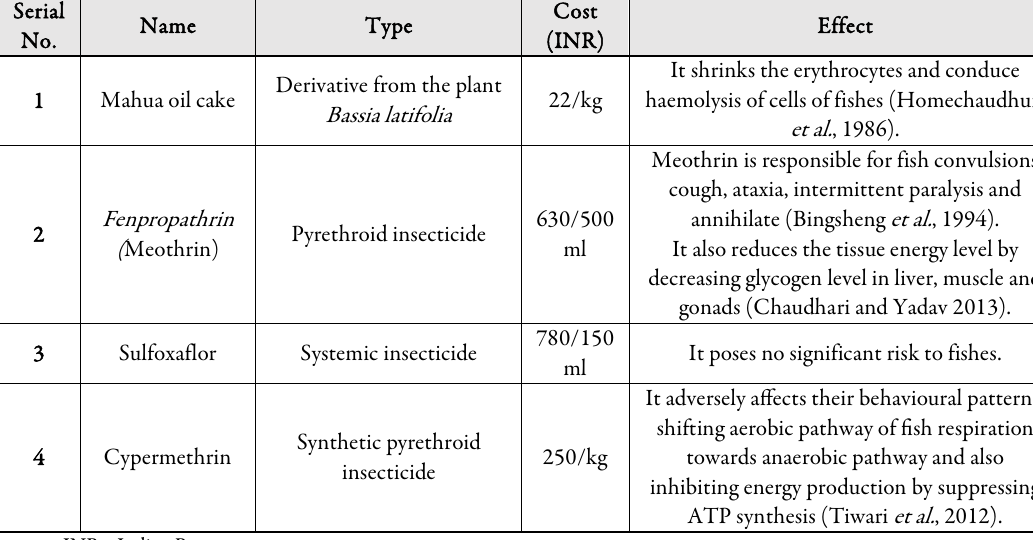
Table 2. Chemicals used for fishing in study